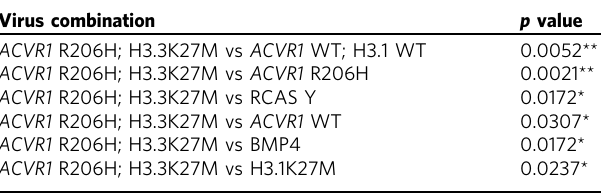
Table 4 ACVR1 R206H and H3.3K27M signi fi cantly increase tumor